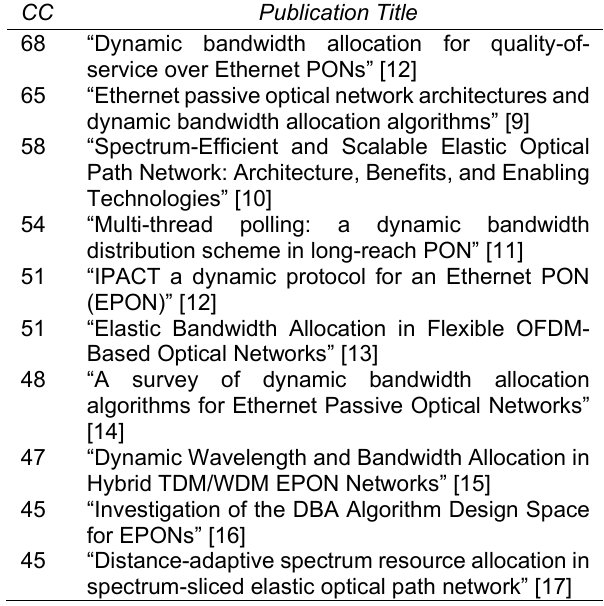
Table. 2 mentions the titles, citation count (CC)